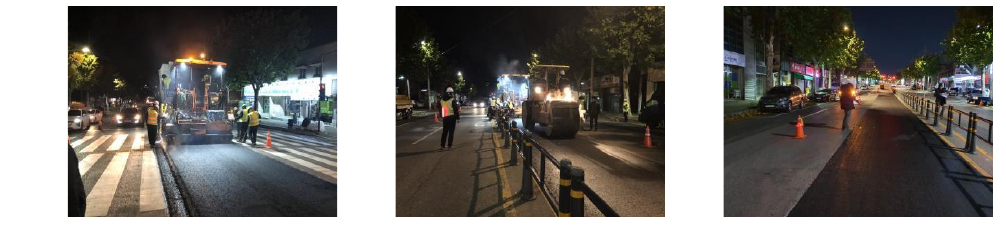
Figure 8. Actual pavement construction.